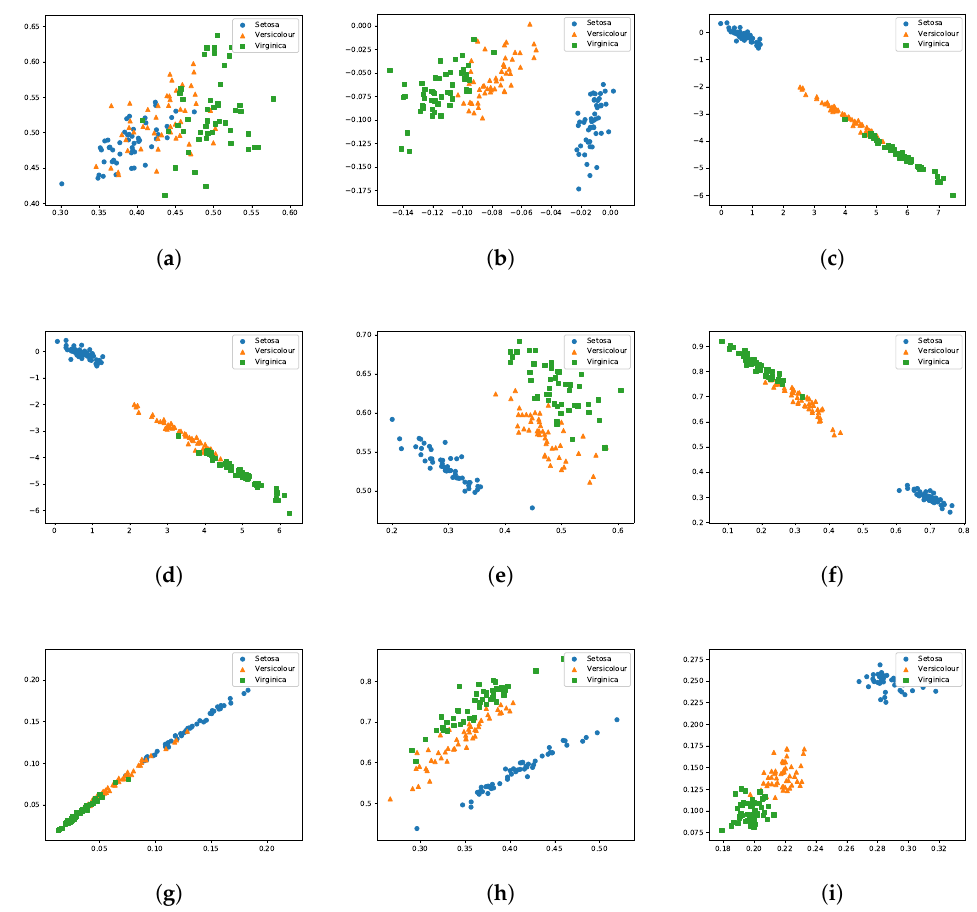
Figure 6. The 2-dimensional visualization of Iris dataset of ( a ) NRP, ( b ) SPCA, ( c ) ELM-AE, ( d ) SELM-AE, ( e ) AE, ( f ) SAE, ( g ) EMO-ELM( f 1 ), ( h ) EMO-ELM( f 2 ) and ( i )